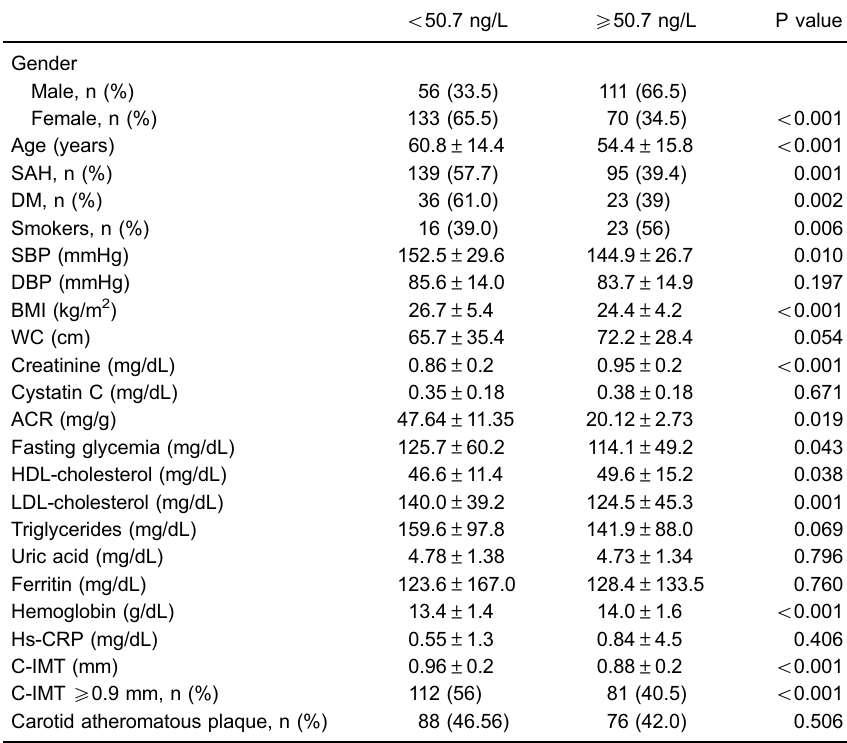
Table 2. Characteristics of the participants according to the 50th percentile of serum 25(OH)D levels.